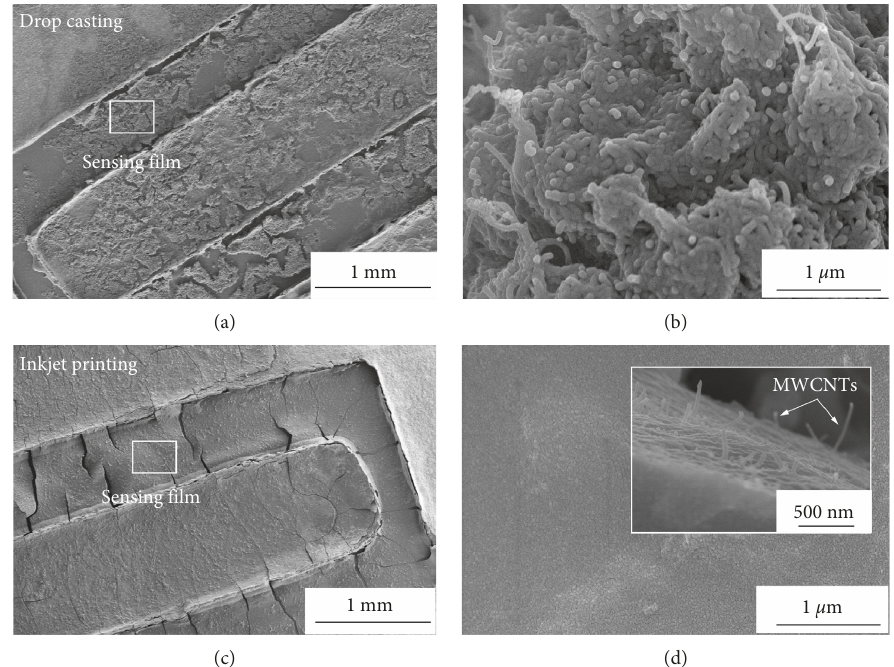
Figure 8: SEM images of MWCNT-PEDOT:PSS sensing film on silver interdigitated electrode using (a-b) drop-casting and (c-d) inkjet